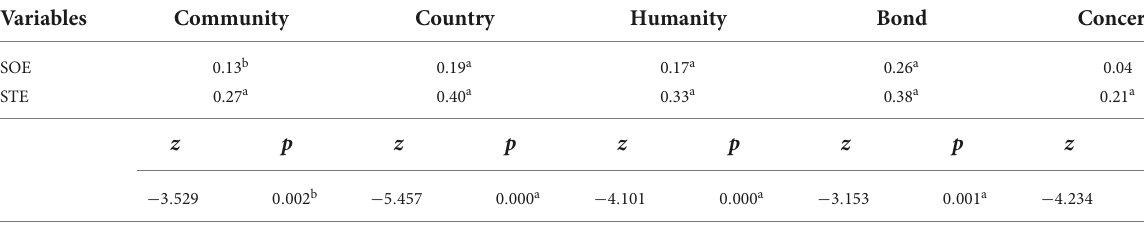
N =403. ThereportedscoresrefertotheaverageofT1andT2.